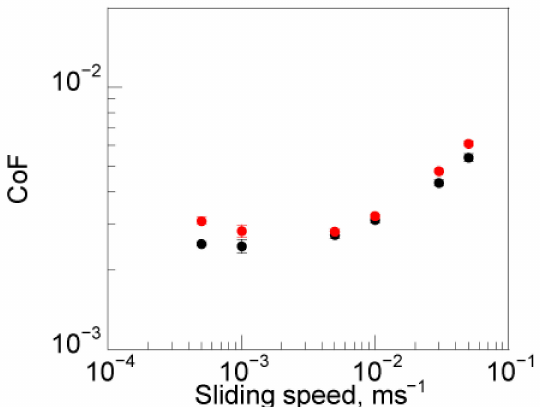
Figure 5. Sliding speed dependence of coefficient of friction (CoF) at the glass ball/poly( N , N -diethyl- N -(2-methacryloylethyl)- N -methylammonium bis(trifluoromethylsulfonyl)imide) (DEMM–TFSI) interface formed by coating process (red circle) or immersion process (black circle) under the normal load of 0.98